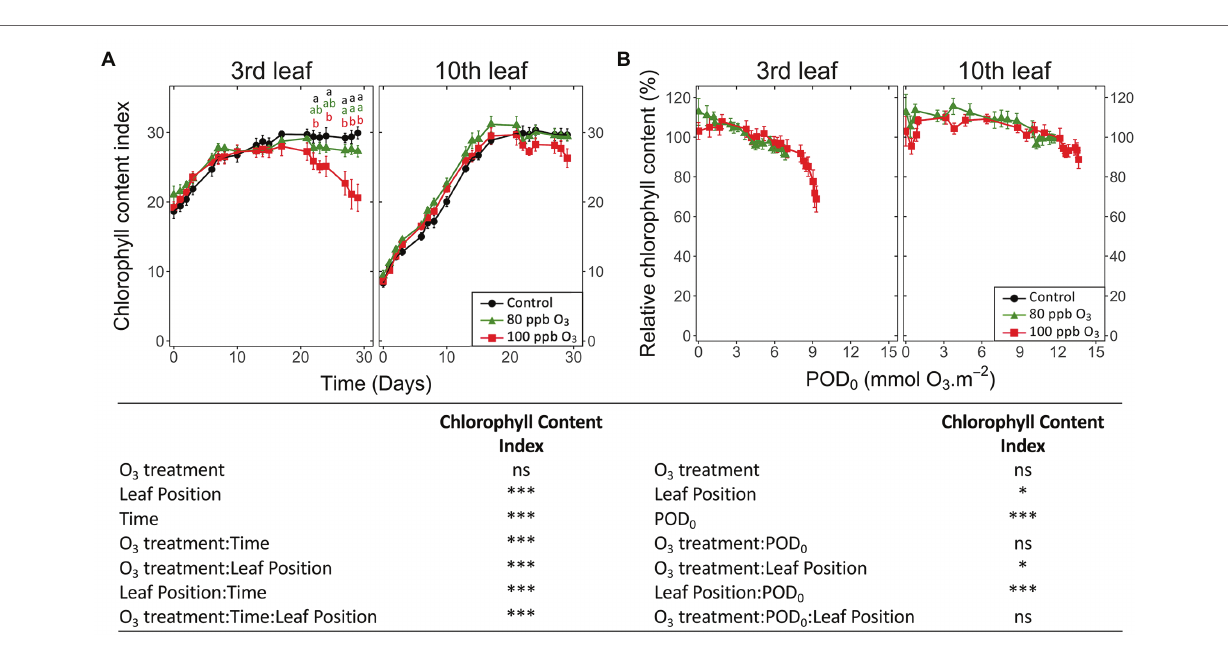
FIGURE 3 | Dynamics of changes in the surface-based concentration of chlorophylls (total chlorophyll content index of Dualex) within hybrid poplar leaves ( Populus tremula x alba ), as a function of assessment time (A) , phytotoxic O 3 dose (POD 0 ; B ), O 3 treatment (charcoal-filtered air ● , 80 ppb O 3 ▲ , 100 ppb O 3 ◼ ), leaf position and interactions [model: lmer(variable) ~ O 3 treatment ∗ leaf position ∗ time + (1 | tree / chamber); ∗∗∗ p ≤ 0.001; ∗ p ≤ 0.05; ns, not significantly different]. Values represent means ± SE, n = 6. Different letters indicate significant differences between treatments at a given assessment date ( post-hoc Tukey’s Honest significant difference, p ≤ 0.05).